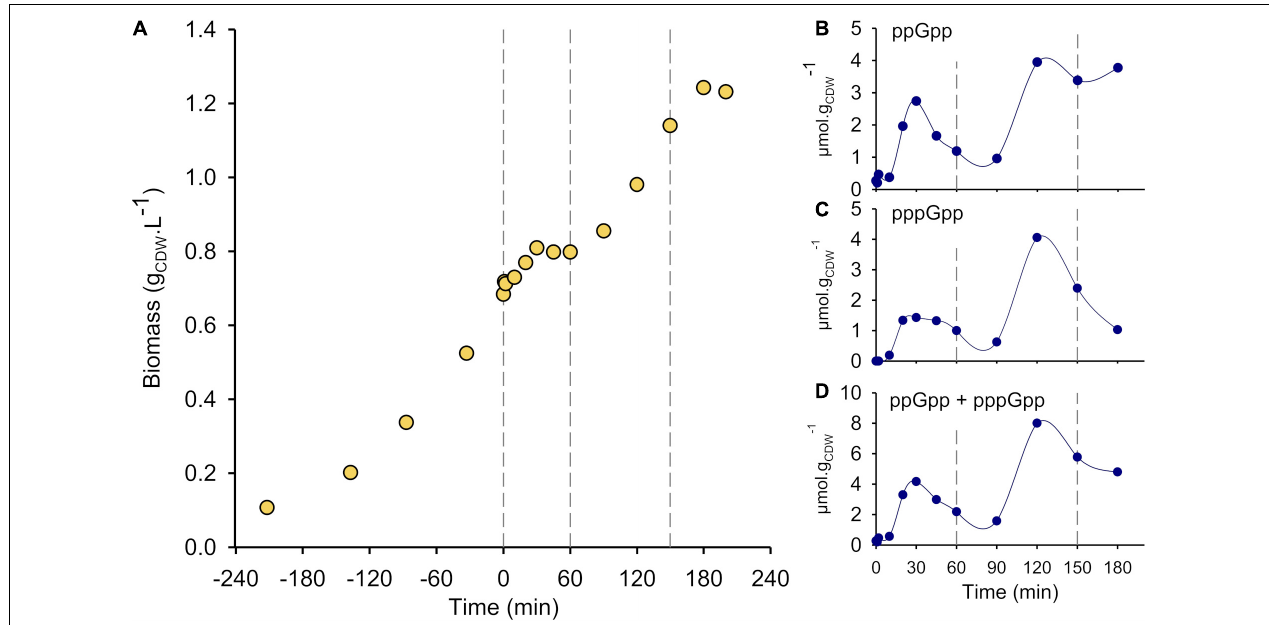
FIGURE 1 | SHX addition leads to severe growth inhibition and triggers ppGpp and pppGpp synthesis. (A) Growth curve of wild type P. putida KT2440 in M9 medium supplemented with 3 g · L − 1 glucose. SHX (0.2 mM) was added at t = 0 min. The growth phases are delimited by vertical dashed lines: before t = 0, initial exponential growth; from 0 to 60 min, growth arrest; from 60 to 150 min, second growth phase; after 150 min, stationary phase. Intracellular concentrations (micromoles per gram of cell dry weight— µ mol g CDW − 1 ) of (B) ppGpp, (C) pppGpp and (D) (p)ppGpp (ppGpp + pppGpp) from 0 to 180 min. The results obtained from the other biological replicates are shown in Supplementary Figure 1